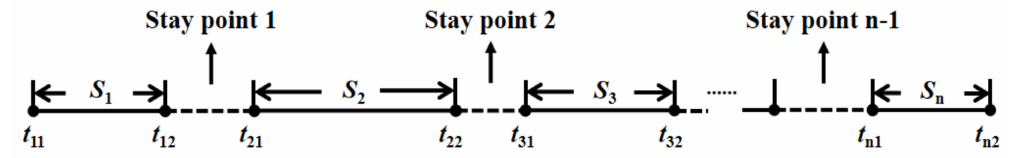
Figure 4. A car sharing order that contains n consecutive travel